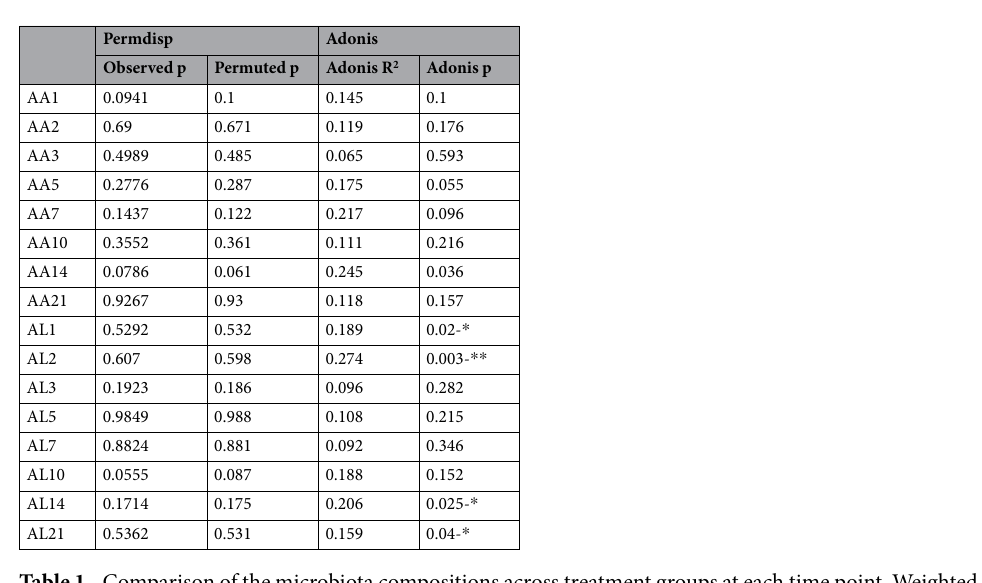
Table 1. Comparison of the microbiota compositions across treatment groups at each time point. Weighted UniFrac beta diversity data were analyzed using the permdisp and adonis functions to identify significant differences in microbiota composition. The adonis function was utilized at each time point to compare the vehicle, treatment, and day 0 groups. * p < 0.05; ** p <